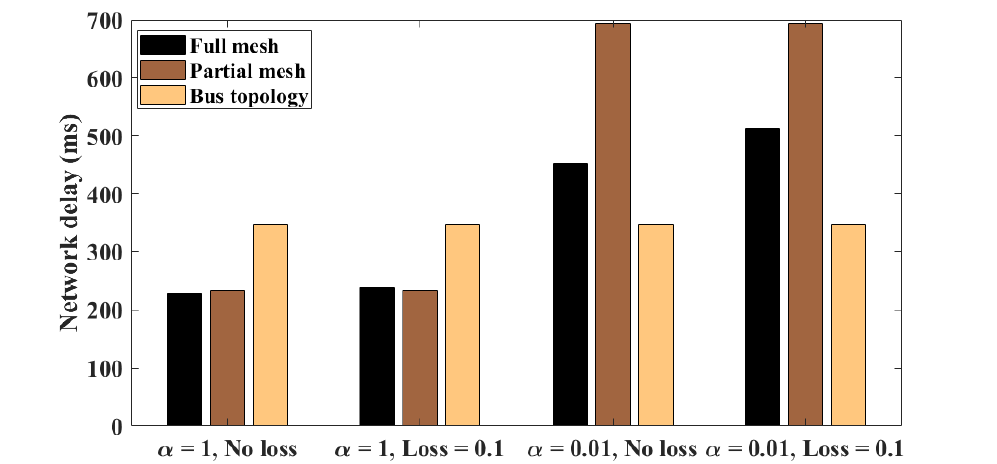
Figure 6. Total network delay for the 3 topologies for the case of probability of loss ( 0.1 ) with step sizes 1 and